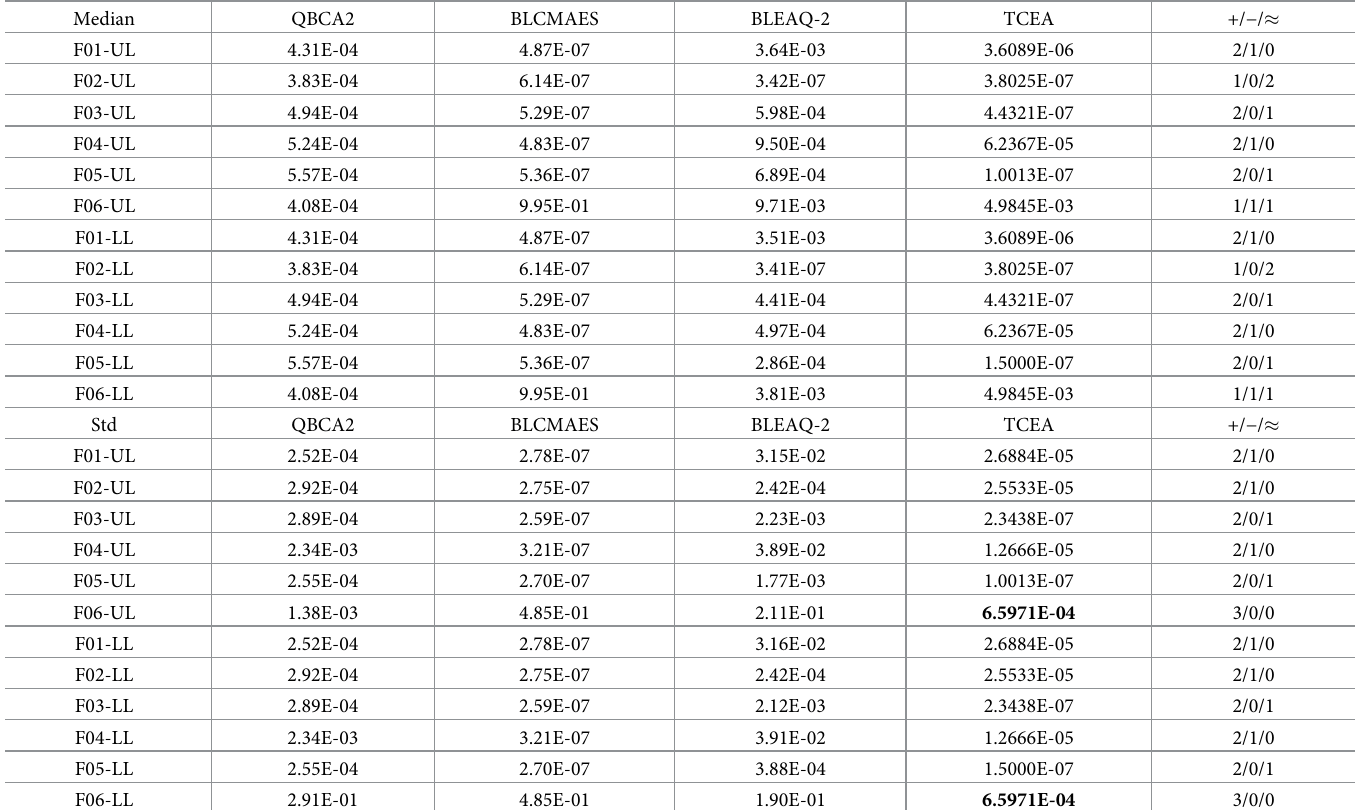
Table 5. UL and LL accuracy statistics from 31 independent runs by QBCA2, BLCMAES, BLEAQ-2 and TCEA on 5-dimensional test